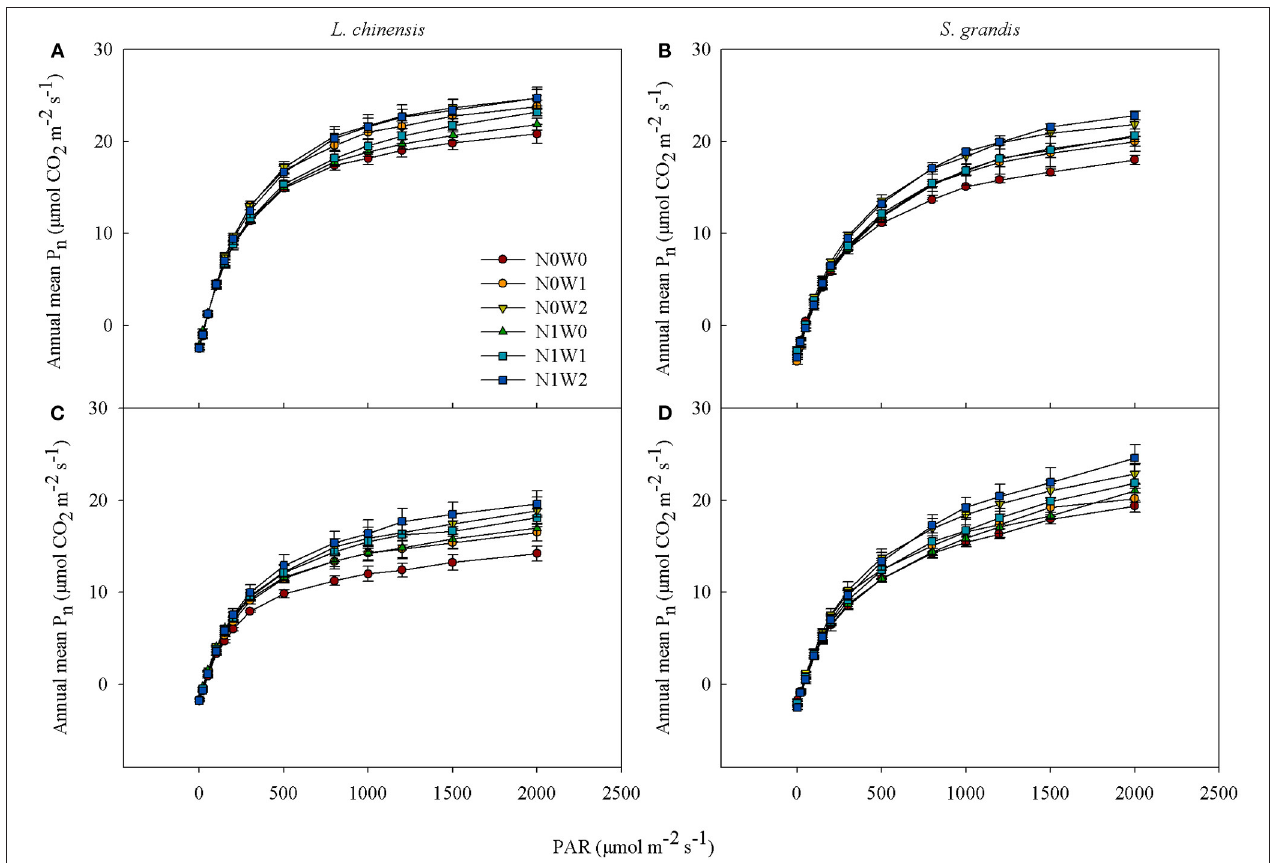
FIGURE 1 | Average values of light response curves of Leymus chinensis (left panels) and Stipa grandis (right panels) across growing seasons in 2012 (A,B) and 2013 (C,D) , respectively. Values represent mean ± SE ( n = 3). Treatments are designated as follows: N0W0, no water supply and no N application (control); N0W1, spring snow addition; N0W2, summer water addition; N1W0, N application; N1W1, spring snow and N application; and N1W2, summer water and N